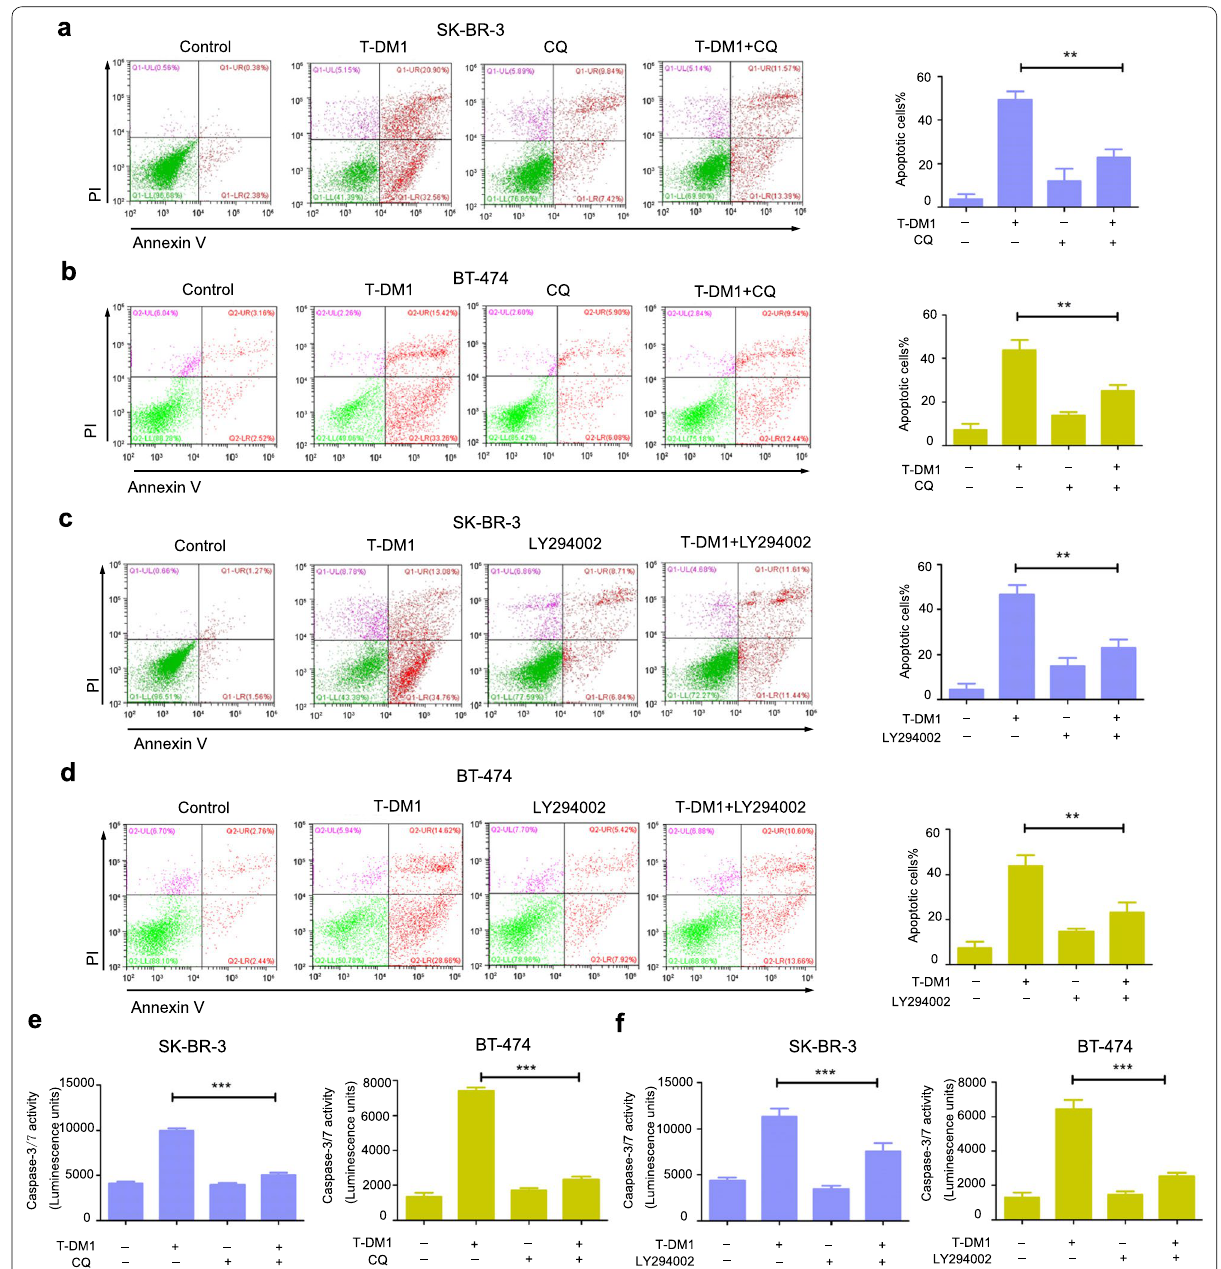
Fig. 4 Inhibition of autophagy reduced T-DM1-induced apoptosis in SK-BR-3 cells and BT-474 cells. SK-BR-3 cells and BT-474 cells are exposed to corresponding concentrations of T-DM1 with or without 5 μM of LY294002 or 10 μM of CQ for 2 days. a – d Proportion of Annexin V/PI-positive cells were analyzed and then presented in bar charts. e , f After treatment with T-DM1 in combination with autophagy inhibitors, the activation of caspase-3/7 was analyzed by commercial kit and presented in bar